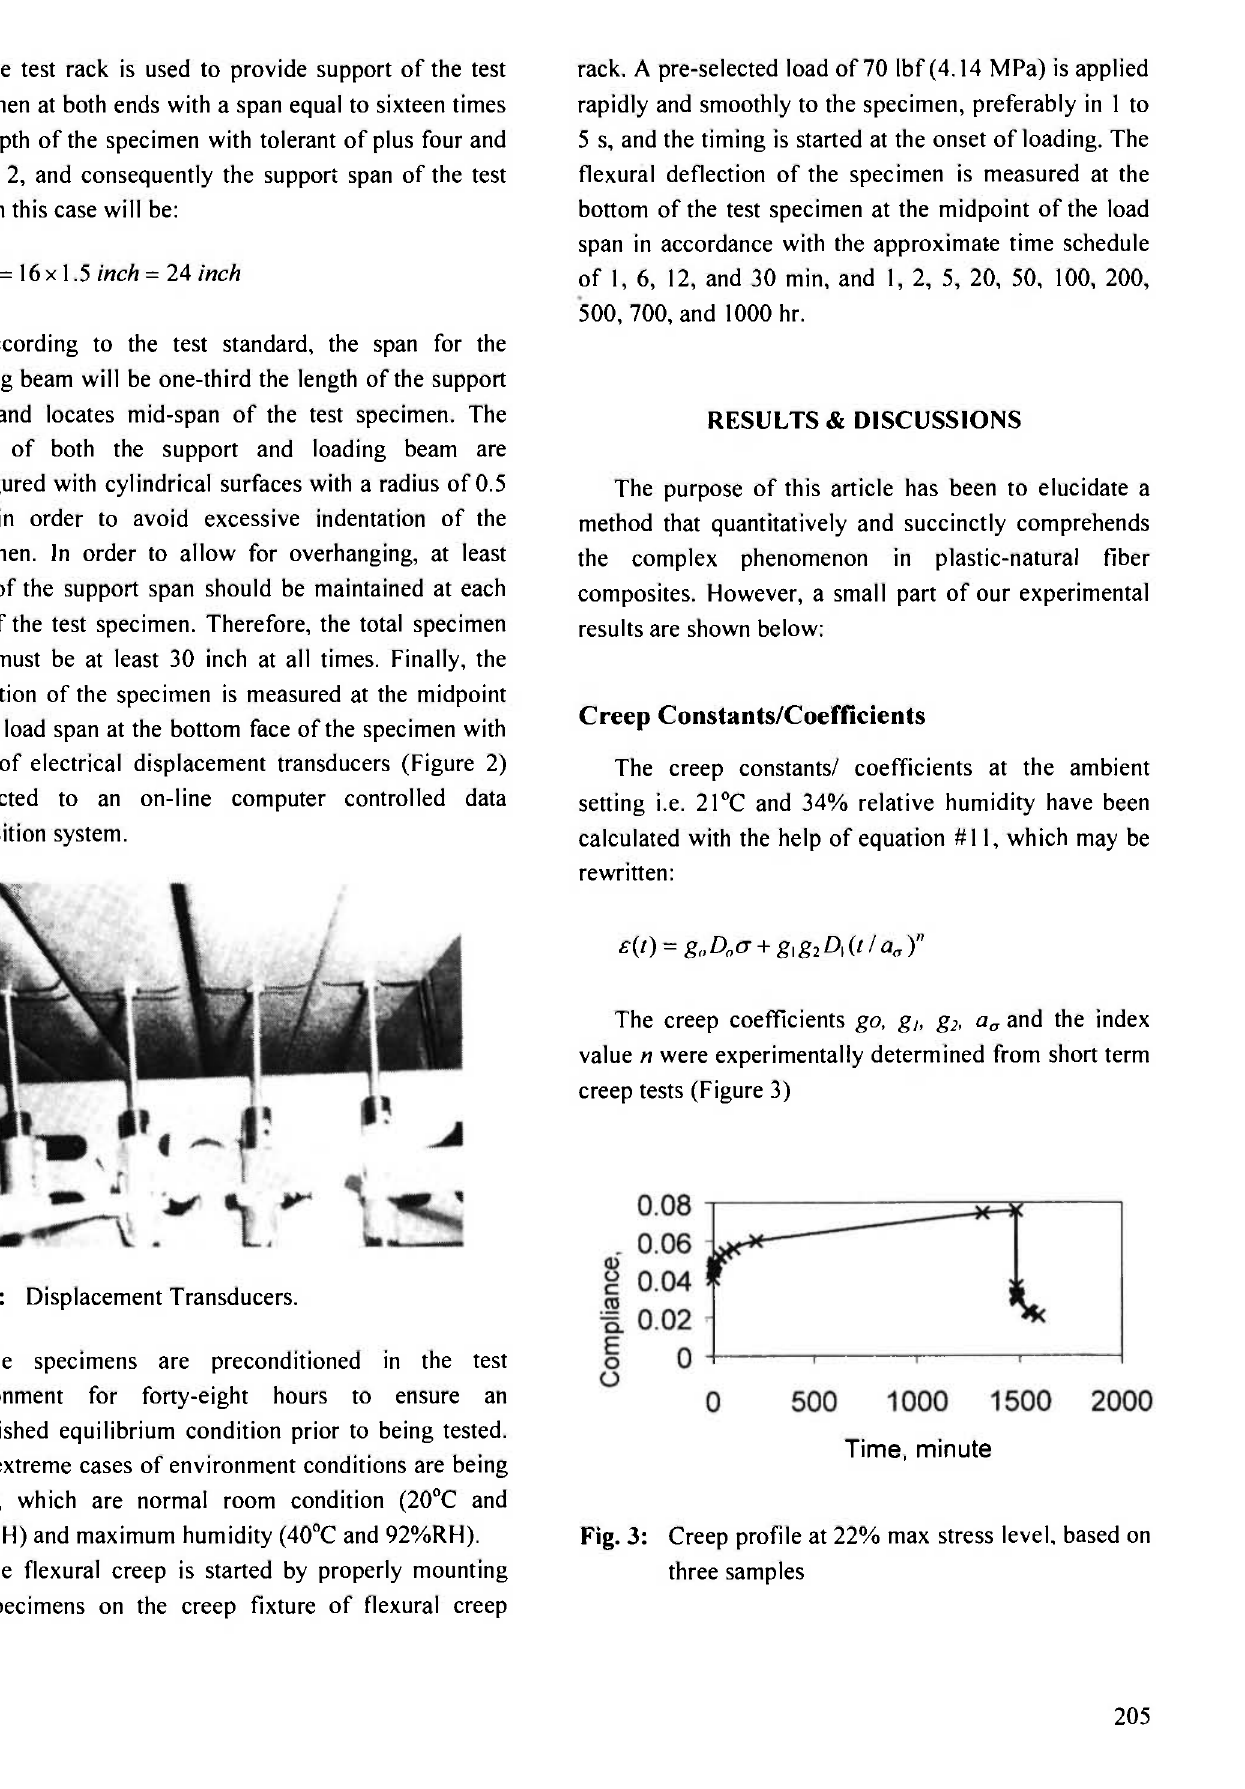
Fig. 3: Creep profile at 22% max stress level, based on three